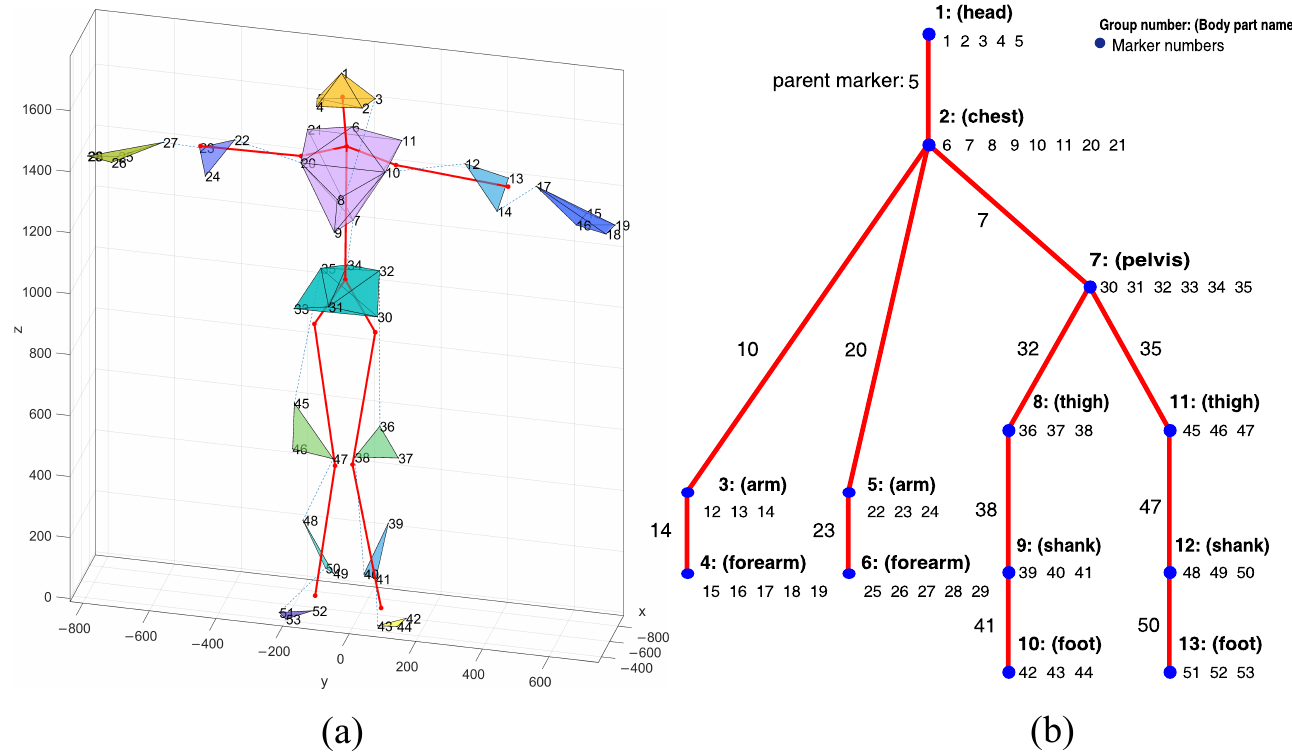
Figure 5. Outline of the body model, with body parts distinguished with individual random colors and underlying skeleton included ( a ), and corresponding parts hierarchy annotated with parents and siblings ( b